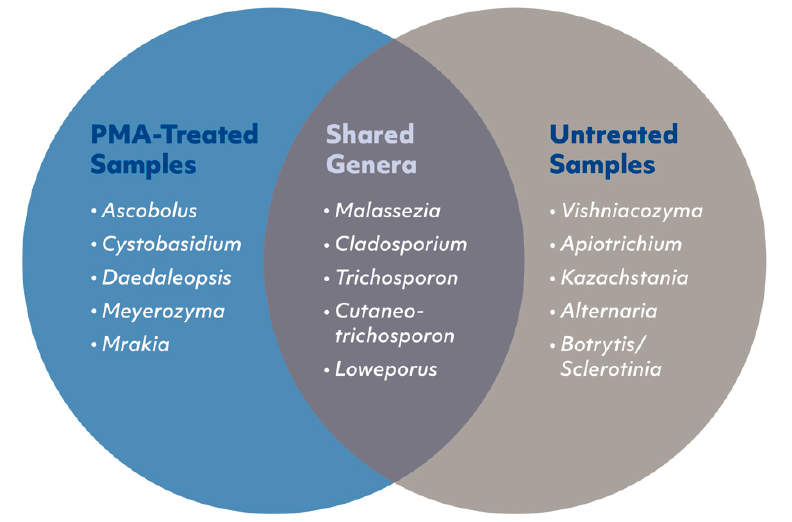
Figure 5. Venn diagram presenting the top five shared and specific fungal genera between propidium monoazide (PMA)-treated and untreated samples. Fungal genera unique to the PMA-treated samples represented 4% of the identified fungal genera (left), fungal genera unique to the untreated samples represented 27% of the identified fungal genera (right), and 69% of the fungal genera were found in both PMA-treated and untreated samples (center).